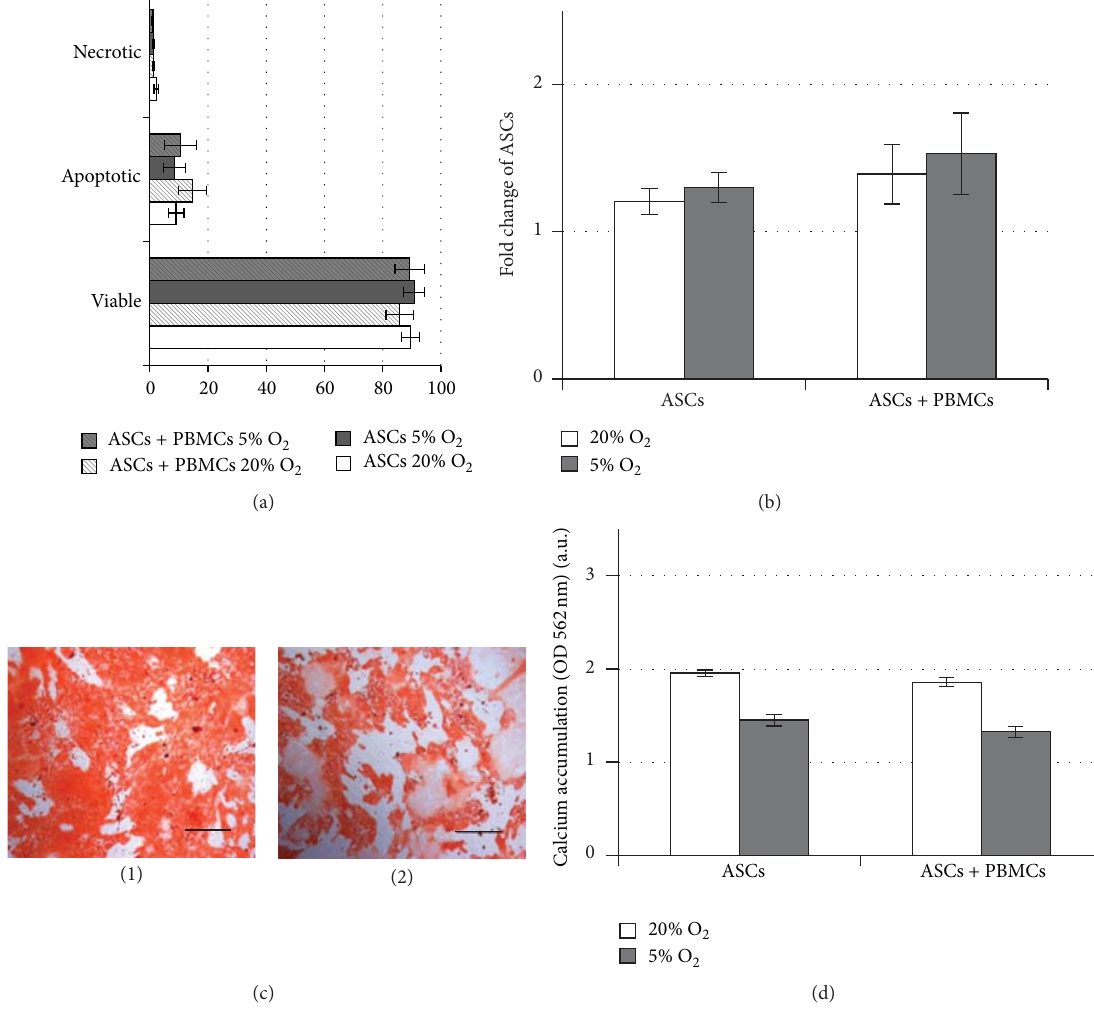
Figure 4: ASC functions after paracrine interaction with PHA-stimulated PBMCs. (a) ASC viability: percentage of viable, apoptotic, and necrotic cells in monoculture and after coculture during 72 h at 20% and 5% O 2 . (b) ASC proliferation: the change in cell number in monoculture and after coculture during 72h at 20% and 5% O 2 . (c) Matrix mineralization of ASCs at 20% (1) and 5% O 2 (2), alizarin red staining: bar 200 𝜇 m. (d) Osteodifferentiation: matrix mineralization in monocultured and cocultured ASCs. ∗ Significant difference between ASC under 20% and 5% O 2 in monoculture. # Significant difference between ASC under 20% and 5% O 2 in